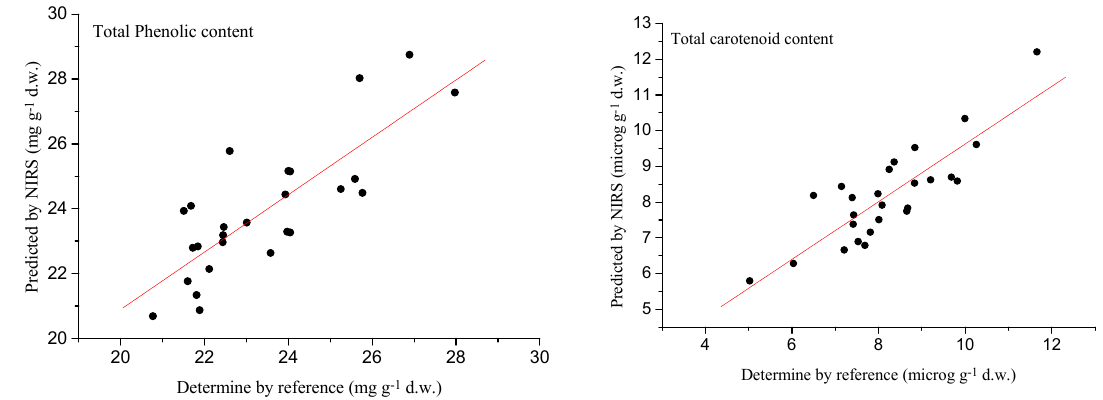
Figure 4. External validation scatter plot for near infrared predicted values versus reference values for total phenolic content (TPC) and total carotenoid content (TCC) in blackberries.